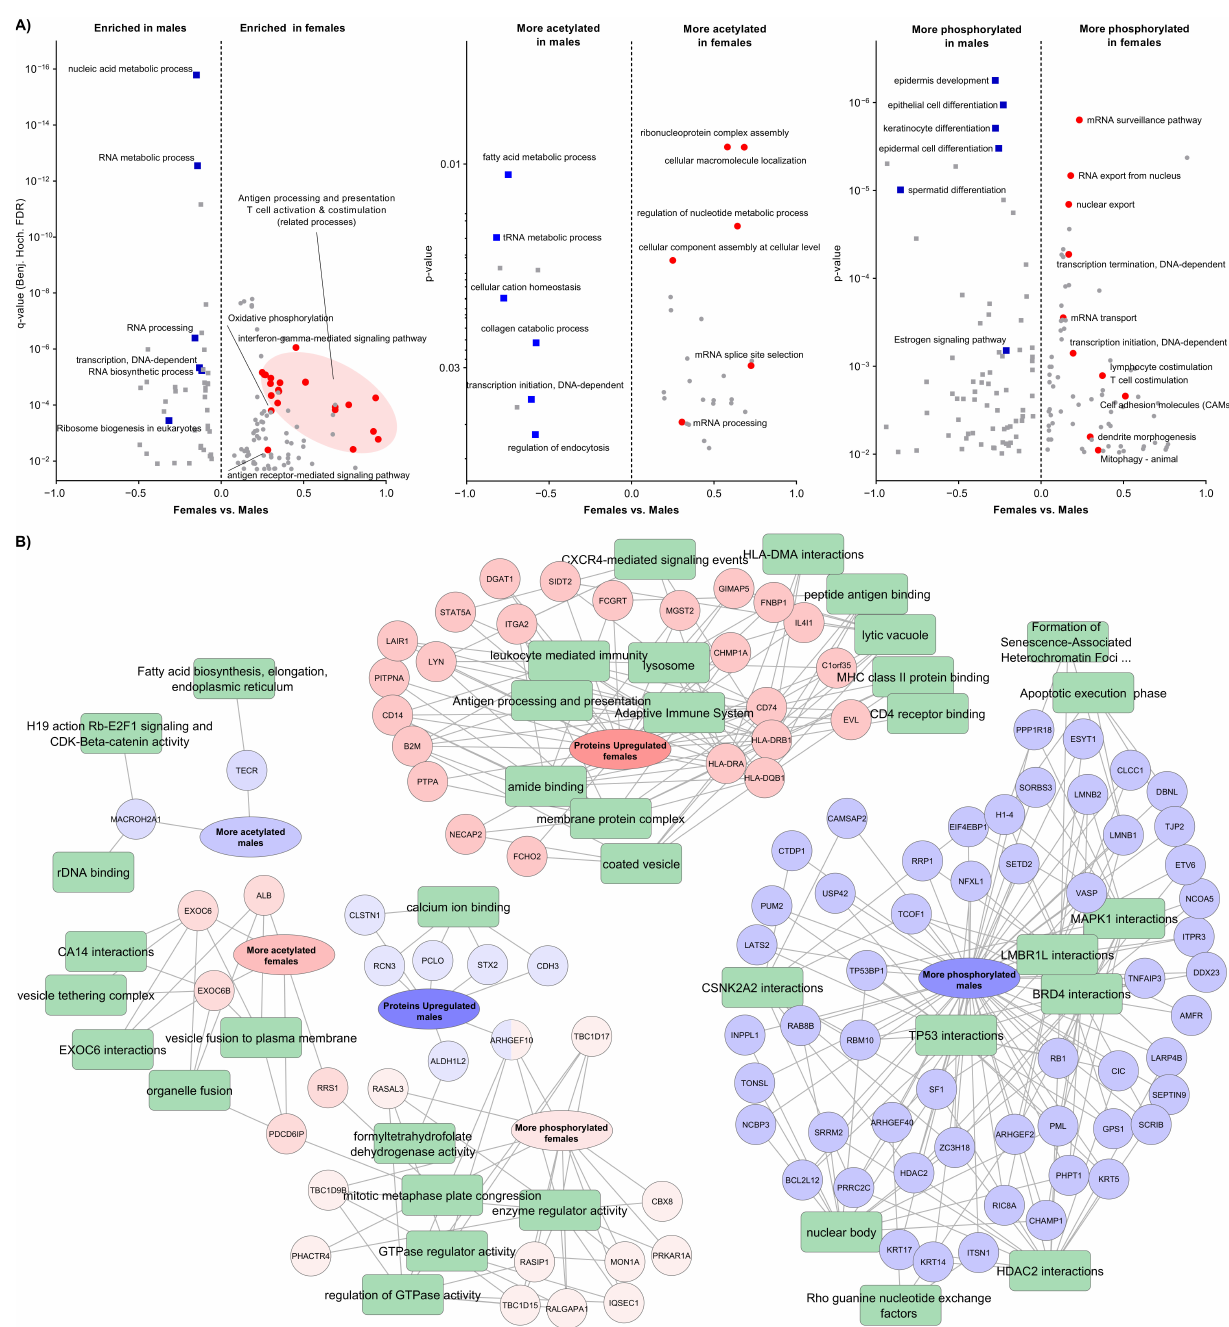
Figure 8. The sex-related differences in the melanoma proteome. ( A ) 1D functional annotation enrichment analysis of the differences at the proteome (left), acetylome (middle), and phosphoproteome (right) levels between women and men. ( B ) Functional annotation-protein network of identified elements dysregulated between women and men in the three datasets. the analysis was performed using the on the ToppCluster function of the ToppGene Suite online version